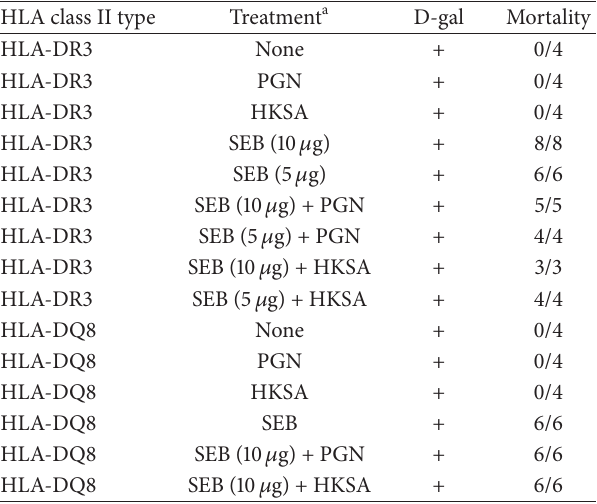
Table 1: Modulation of SEB-induced TSS by staphylococcal PAMPs. HLA class II type Treatment a D-gal